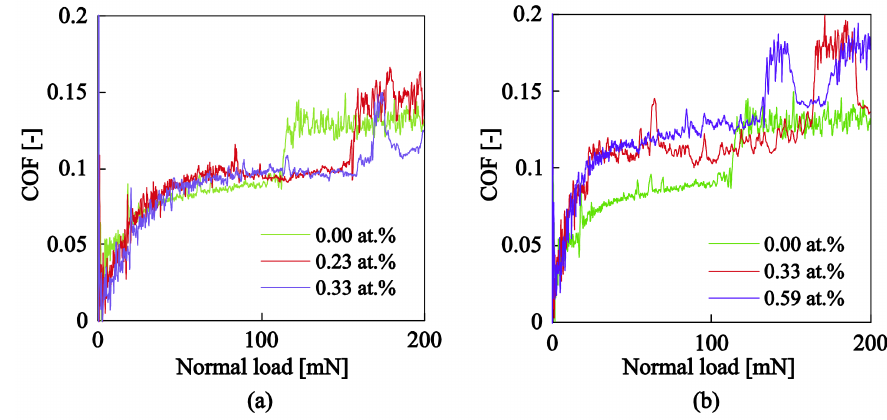
Figure 12. Coefficient of friction as a function of applied load for ( a ) a–C:H:Ag and ( b ) a–C:H:Ti nanocomposite